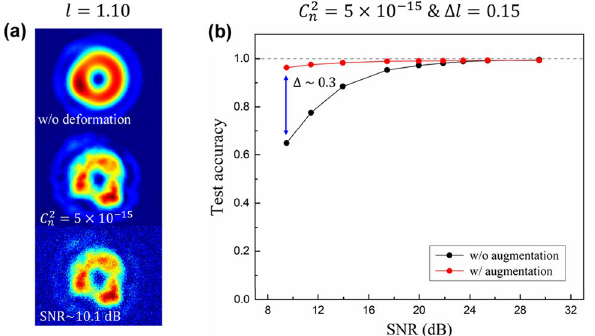
Figure 8. Data augmentation for enhancing noise tolerance. ( a ) Deformation of field distribution caused by AT (middle) and additive Gaussian noise (bottom). ( b ) Recognition accuracy against SNR. Black (red) circles show the result of a model trained without (with) data augmentation. Here, the SNR represents the average value for each test